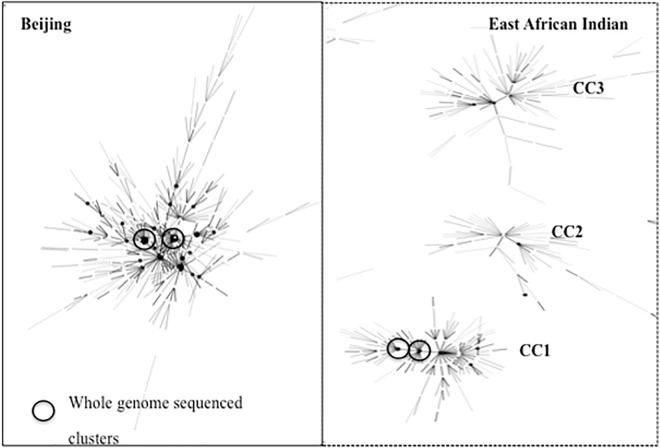
MIRU-24 minimum spanning tree of the predominant M. tuberculosis lineages identified in NSW, Australia.MIRU-24–24-locus mycobacterium interspersed repetitive unit strain typing method; Solid box shows single large clonal complex for Beijing; Dotted box shows 3 independent clonal complexes of East African Indian strain lineage; CC1 –clonal complex 1; CC2 –clonal complex 2; CC3 –clonal complex 3; Circles indicate clusters that were subjected to whole genome sequencing.